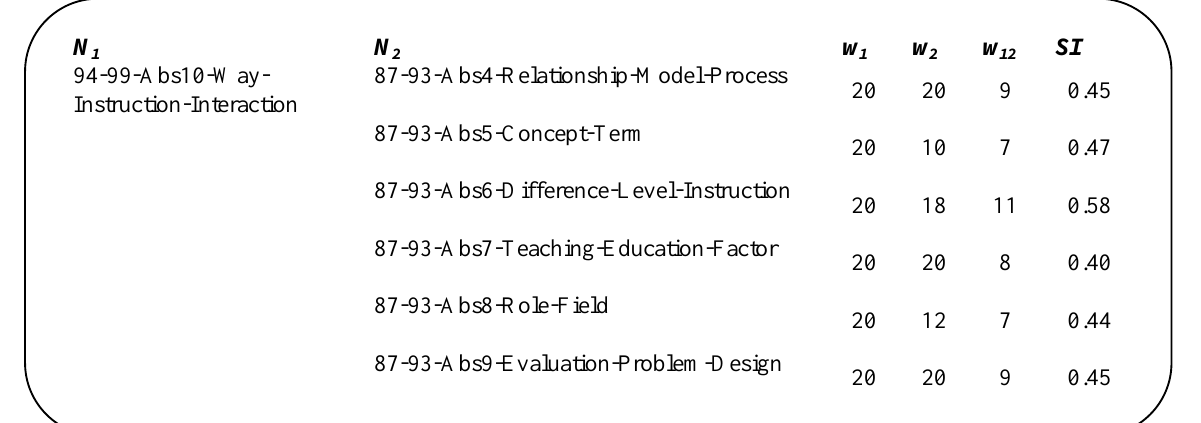
Figure 9 . Similarity index for 94-99-Abs10-Way-Instruction-Interaction.